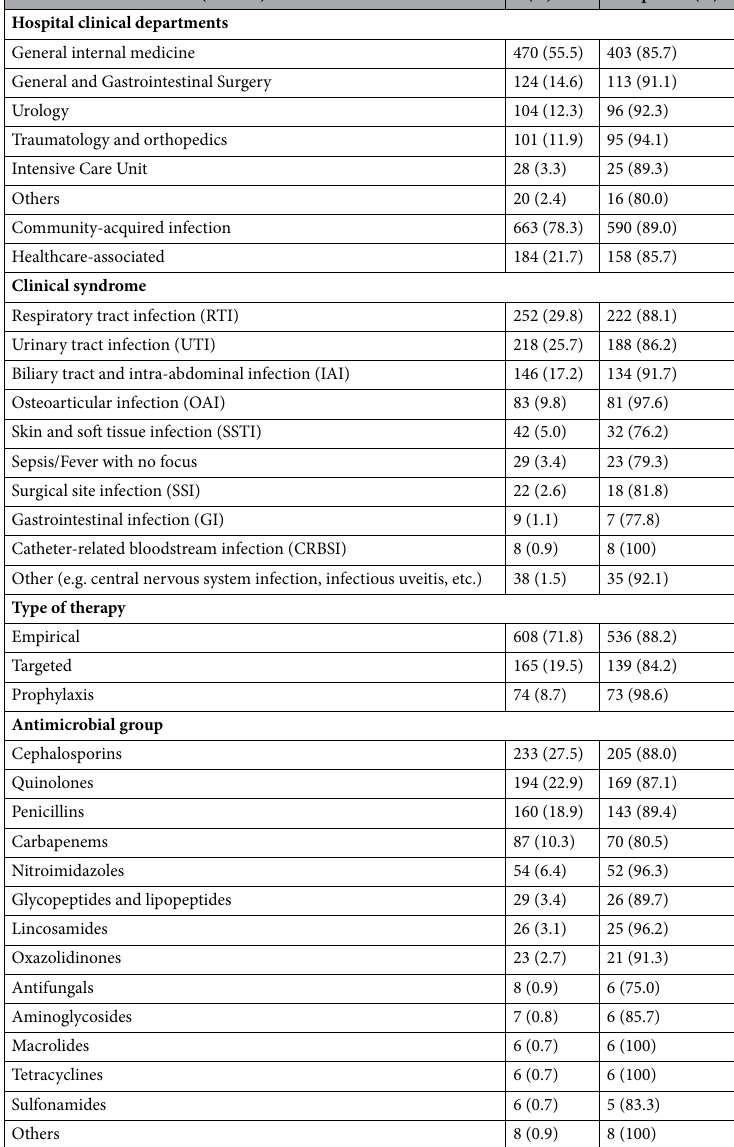
Table 1. Clinical and therapeutic characteristics of patients with pharmacist interventions.